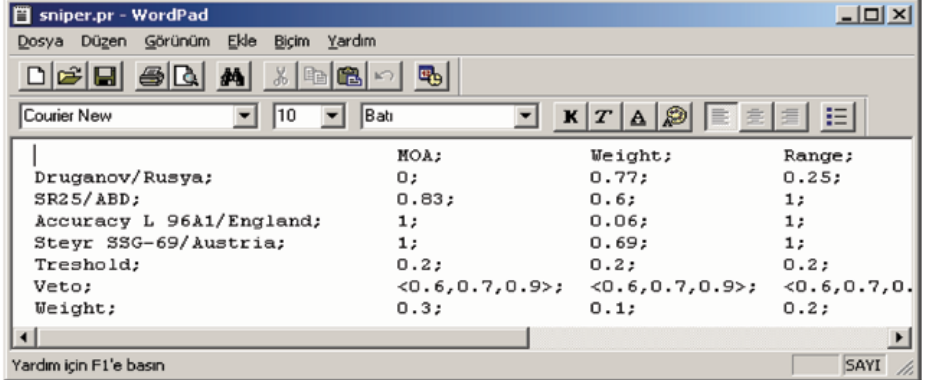
Fig. 3. Input file example for outranking